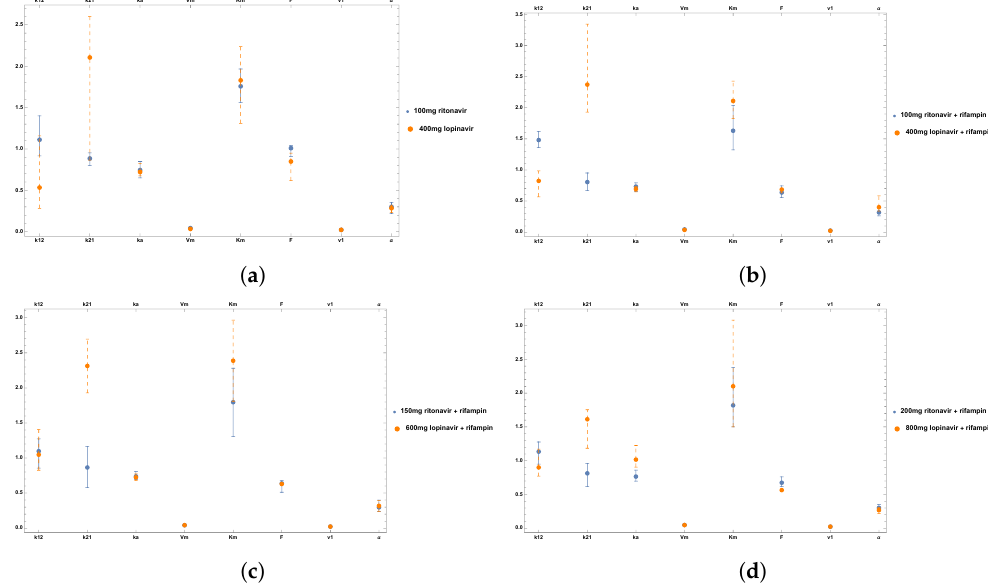
Figure 8. Different Lopinavir and ritonavir dose regimens with 600 mg rifampin dose. ( a ) Day one. ( b ) Day two. ( c ) Day three. ( d ) Day